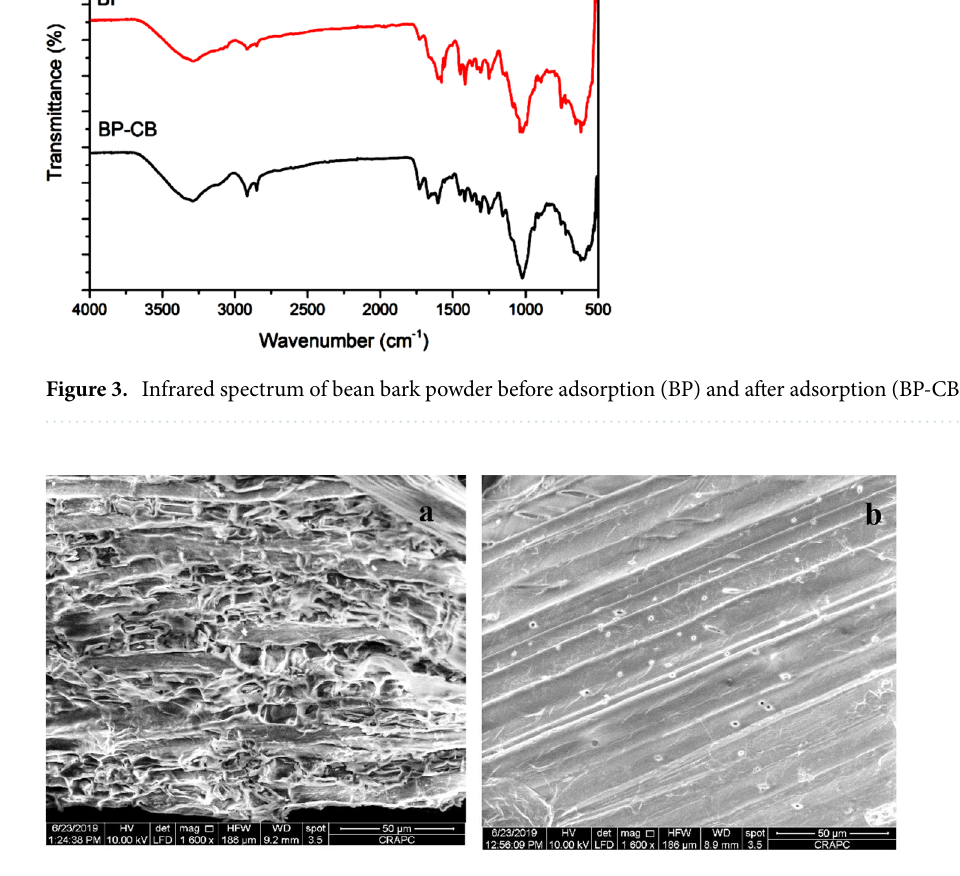
Figure 4. SEM images for Bean peel (BP) before adsorption ( a ) and Bean peel-dye (BP-CB) after adsorption ( b